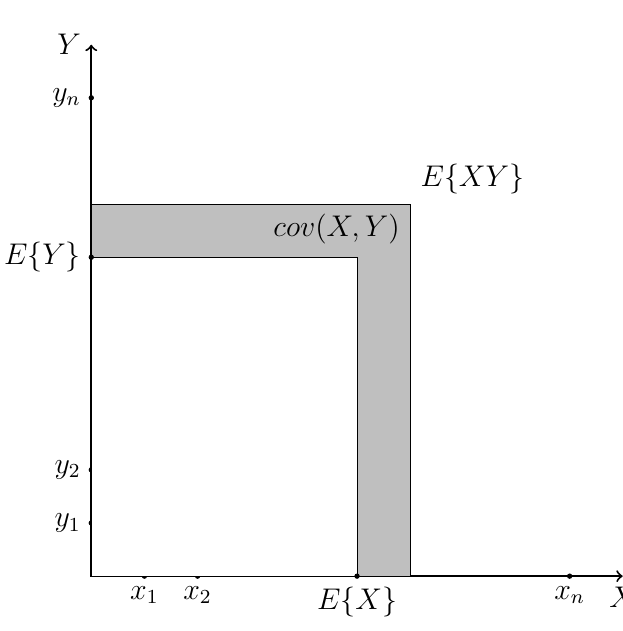
Figure 2: Covariance of X and Y is the weighted averaged Euclidean area differ-